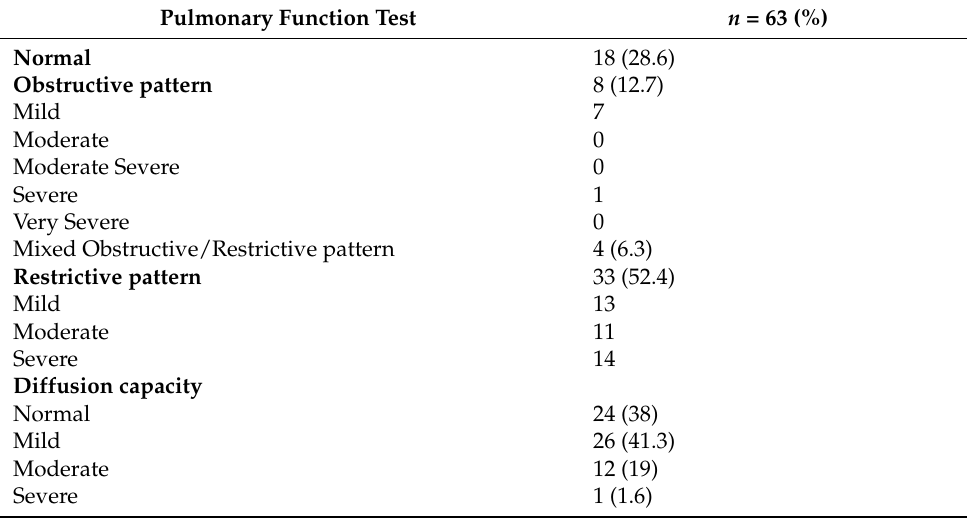
Table 5. Pulmonary function test findings in patients with post-COVID-19